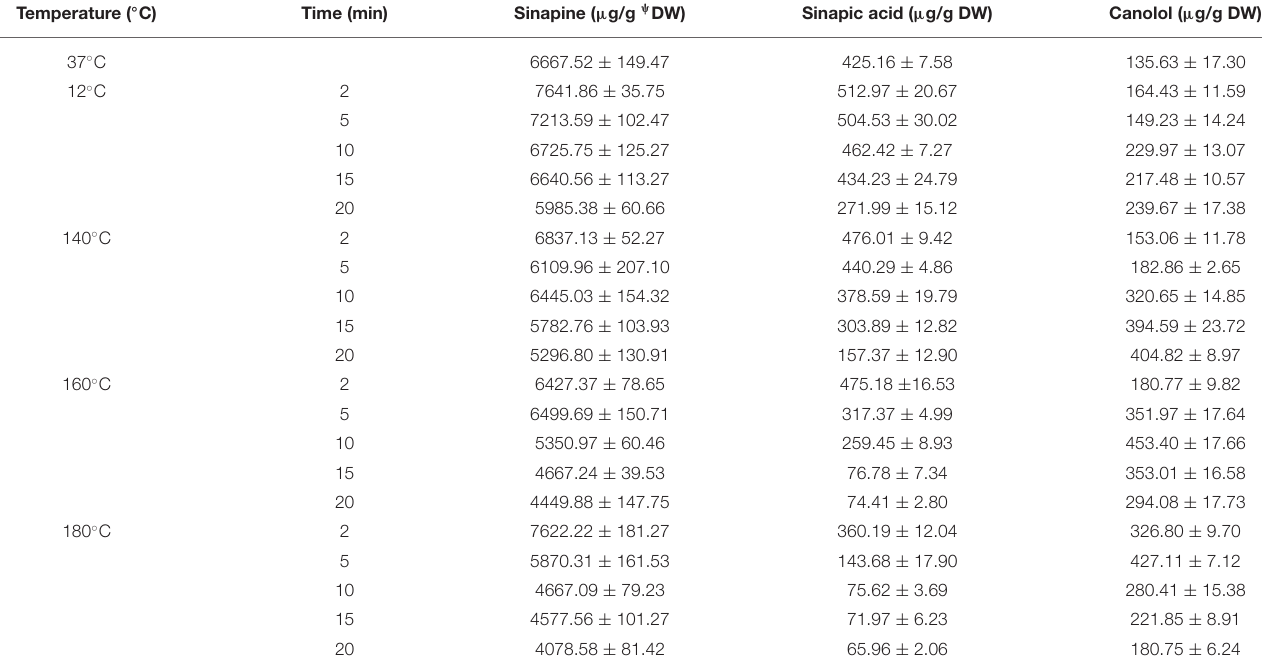
TABLE 1 | Effect of pre-treatment time and temperature on changes in major sinapates.